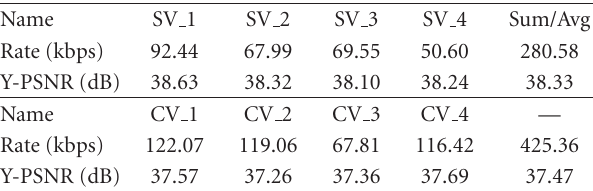
Table 2: Encoding characteristics of the test sequences.